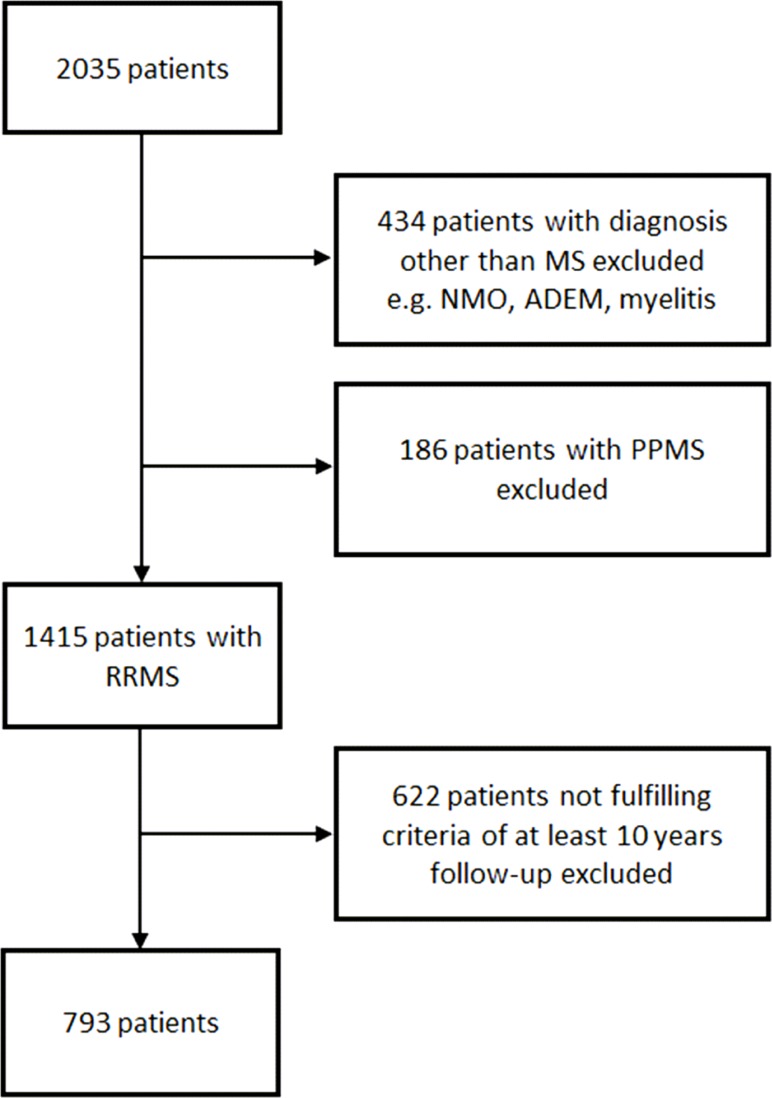
Inclusion flow chart.Abbreviations: ADEM = acute demyelinating encephalomyelitis; MS = multiple sclerosis; NMO = neuromyelitis optica; PPMS = primary progressive MS; RRMS = relapsing-remitting MS